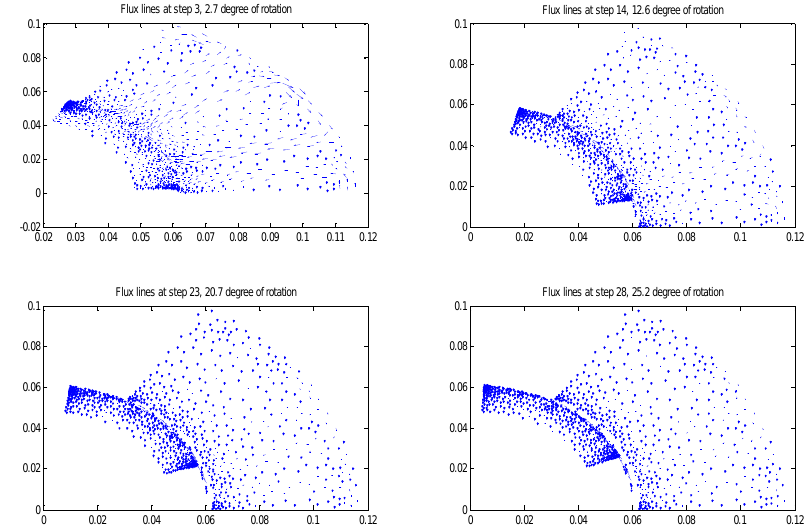
Figure 2. Flux lines in the machine at four di ff erent moments (healthy